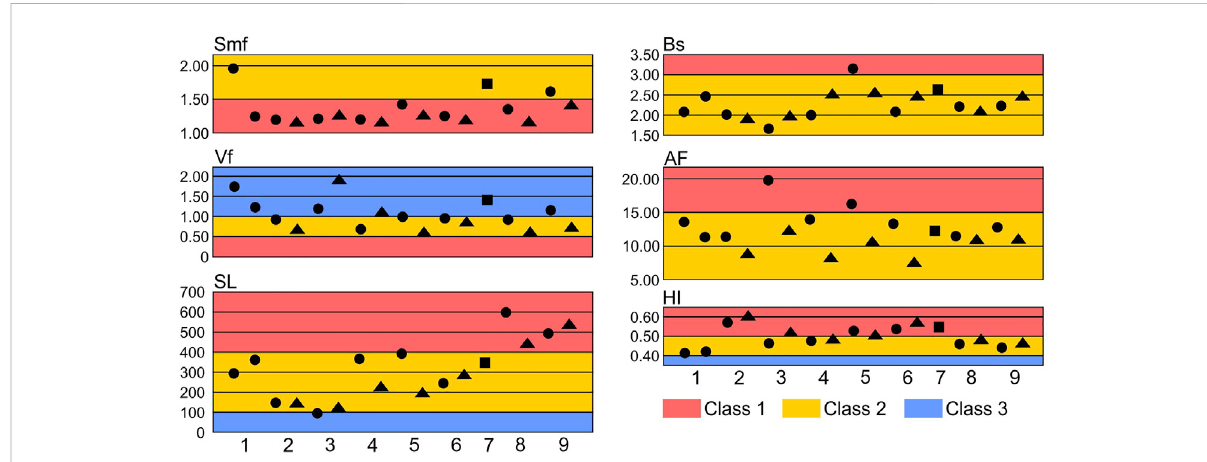
FIGURE 3 Geomorphicindices ofthe strike-slip basins along theNorthernSumatran Fault: Smf, mountain front sinuosity; Vf, valley width-to-height ratio; SL, stream length-gradient index; Bs, index of basin shape; AF, asymmetric factor; HI, hypsometric integral. The average values and classes of the geomorphic indices measured from the eastern (triangle shapes) and western (circular shapes) basin-bounding faults. The Jagong Jeget Basin is measured from the main basin-bounding fault (rectangle shapes). Numbers at the base of the chart correspond to the names of the strike-slip basins and they follow the order in the result